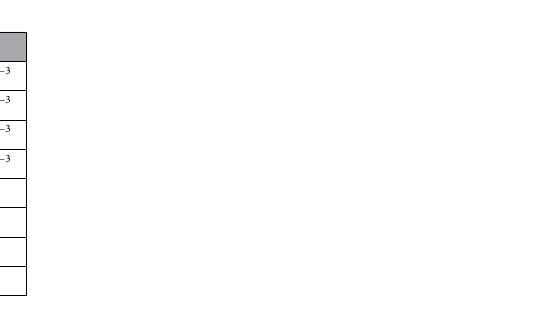
Table 2. N ( E F ), ϴ D and calculated T c for the crystalline (c-) and amorphous (a-) samples studied.